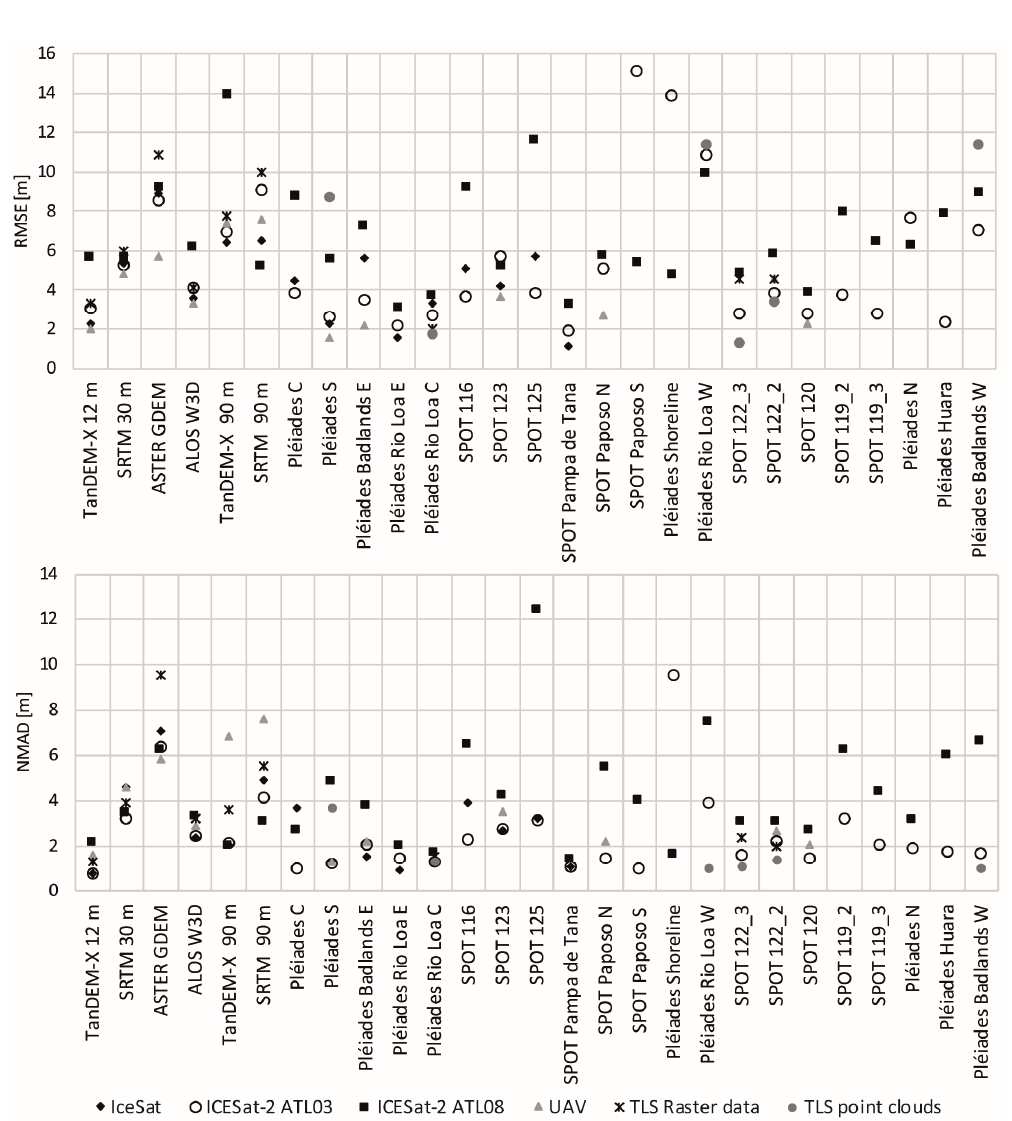
Figure 5. Comparison of all calculated overall accuracies for each digital elevation model For all global DEMs, the lowest RMSE and NMAD values are detectable for the TanDEM-X 12 m dataset. The highest RMSE of 5.7 m was calculated for TanDEM-X with the ICESat-2 ATL08 dataset, the lowest with the UAV dataset (2.0 m). The NMAD is generally lower with values between 0.8 m